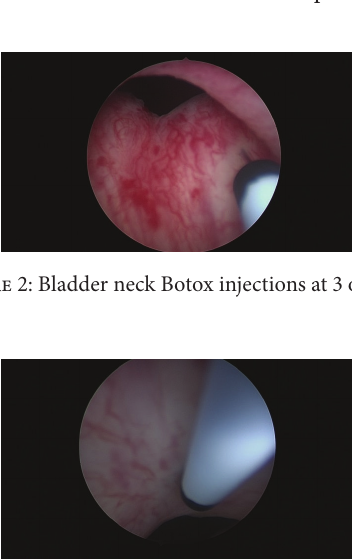
Figure 3: Botox injection over anterior bladder neck.